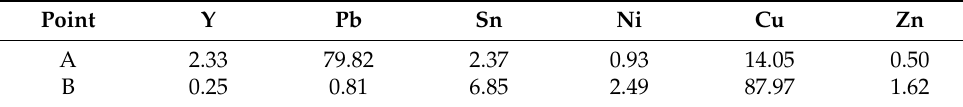
Table 1. EDS results of the point in Figure 7c (wt.%).